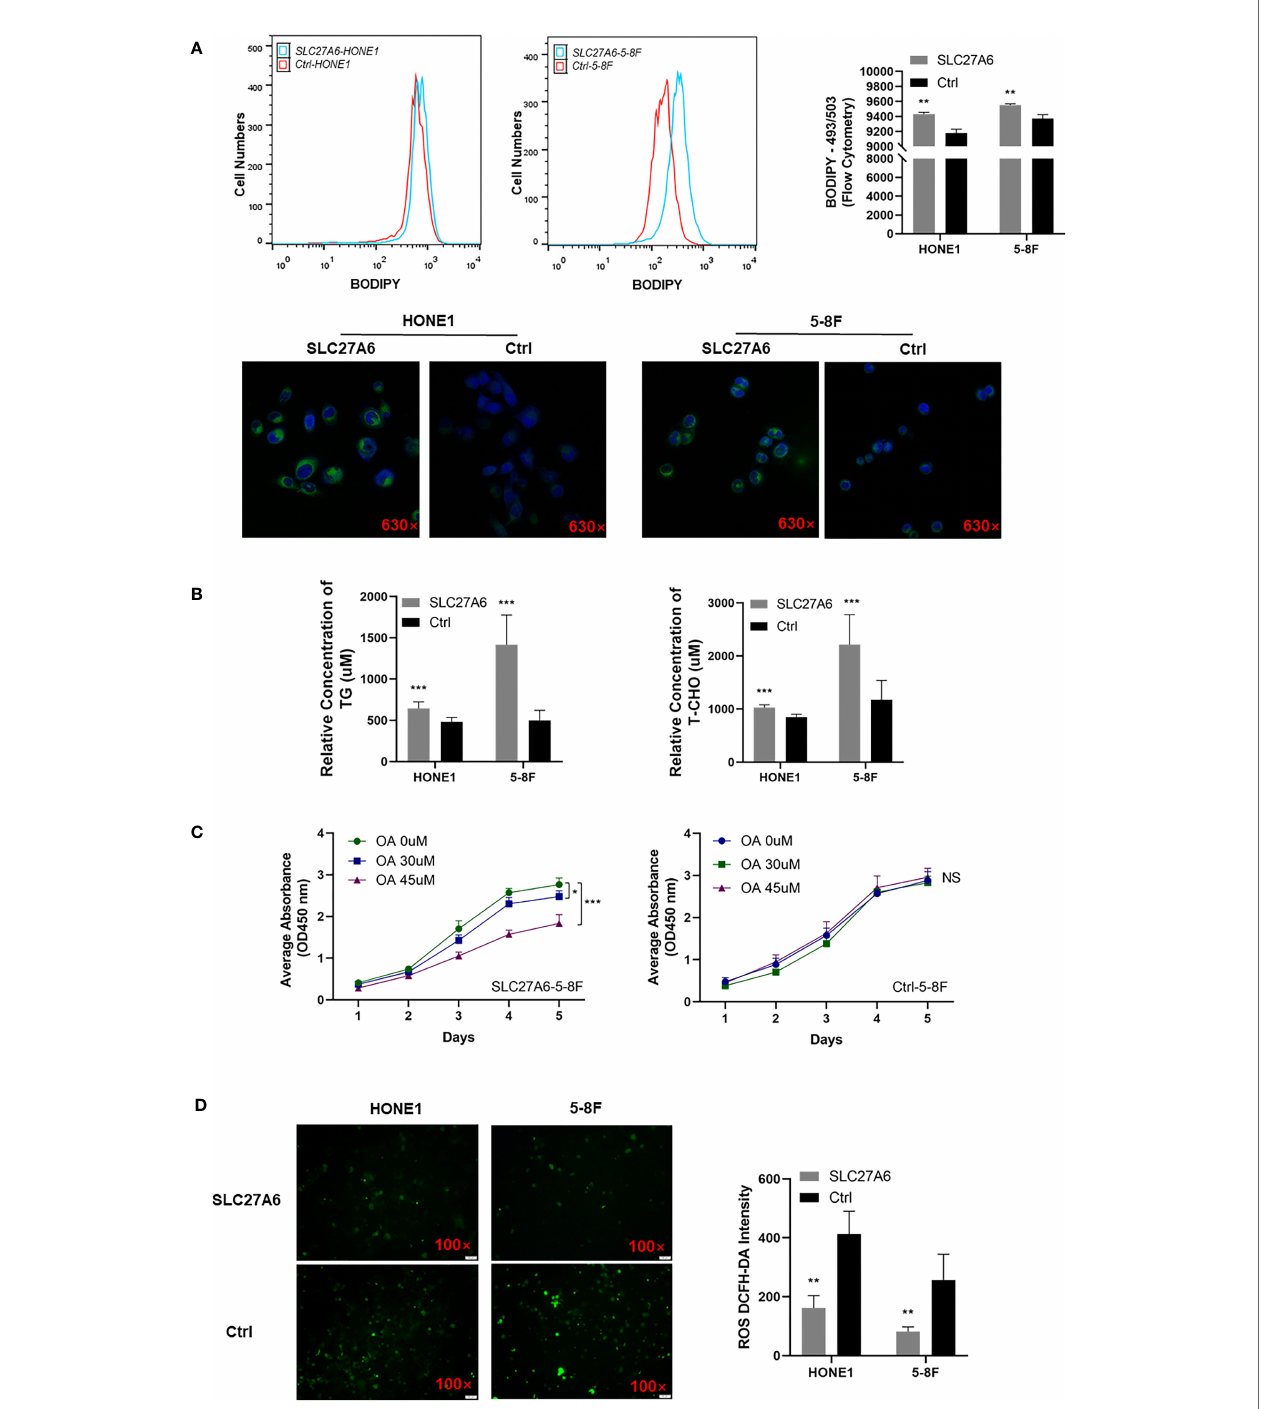
FIGURE 6 | Overexpression of SLC27A6 induces lipid accumulation inhibiting cell proliferation in NPC cell lines. (A) LDs incubated with BODIPY (493/503) (green) and nuclei with DAPI (blue) in NPC cell lines. Magni fi cation ×630. (B) The relative concentration of TG and T-CHO in SLC27A6-HONE1 and SLC27A6-5-8F cells contrasted to control cells. (C) Cell proliferation with OA treatment in SLC27A6-5-8F cell (left panel) and control group (right panel) measured by CCK-8 assay (OD=450 nm). (D) ROS detection in SLC27A6-HONE1/5-8F and Ctrl-SLC27A6/5-8F, followed by intensity analysis. Magni fi cation ×100. NS, no signi fi cance > 0.05; * P < 0.05; ** P < 0.01; *** P <